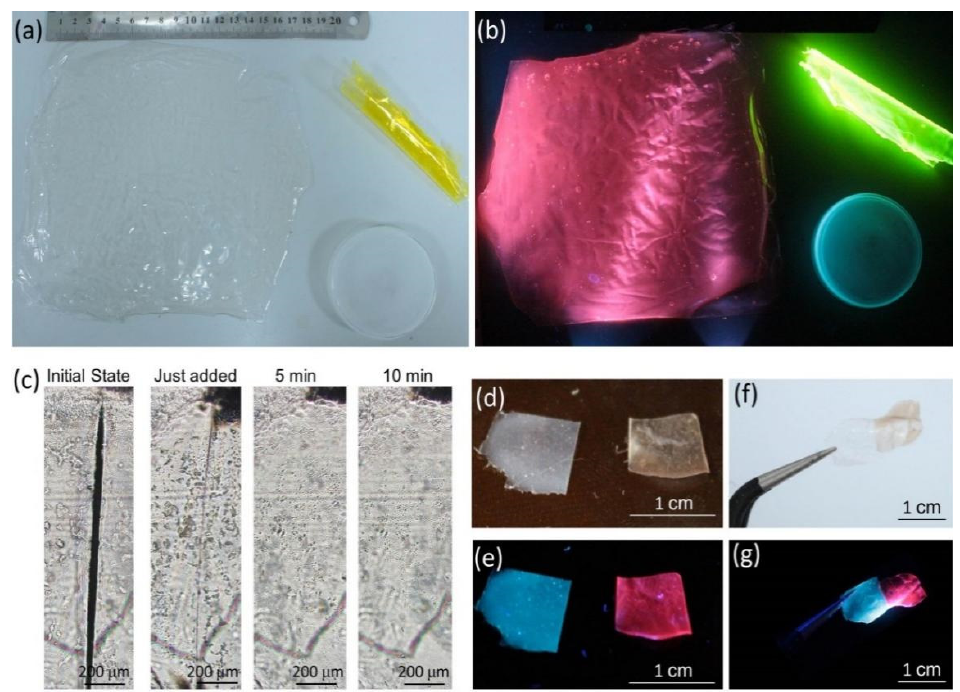
Figure 4. Photographs of the Cu-MMI NCs/PVA film, Au-ATT NCs/PVA film, and Au-BSA NCs/PVA film under ( a ) room light and ( b ) 365 nm excitation. ( c ) The light microscope photographs demonstrating the self-healing process of the Cu-MMI NCs/PVA film (from left to right). ( d ) The photographs of the separated Cu-MMI NCs/PVA and Au-BSA NCs/PVA films under room light and ( e ) under 365 nm excitation. ( f ) The photographs of the separated Cu-MMI NCs/PVA and Au-BSA NCs/PVA films under room light and ( g ) under 365 nm excitation.